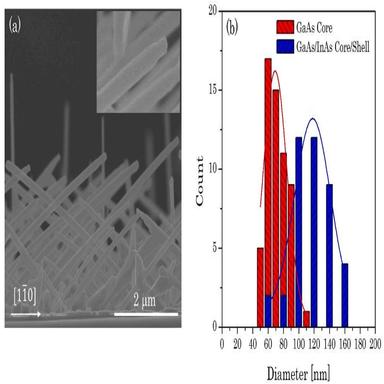
a) Side-view SEM image of the as-grown GaAs/InAs core/shell NWs and b) their diameter distribution in comparison with that of the GaAs core.